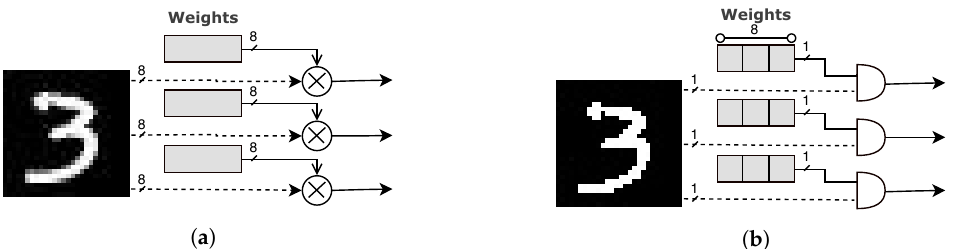
Figure 3. Multiplication in the convolutional layer: ( a ) 8-bit input images require the use of conventional multipliers. ( b ) Input thresholding creates binary images [13], enabling the employment of AND gates rather than